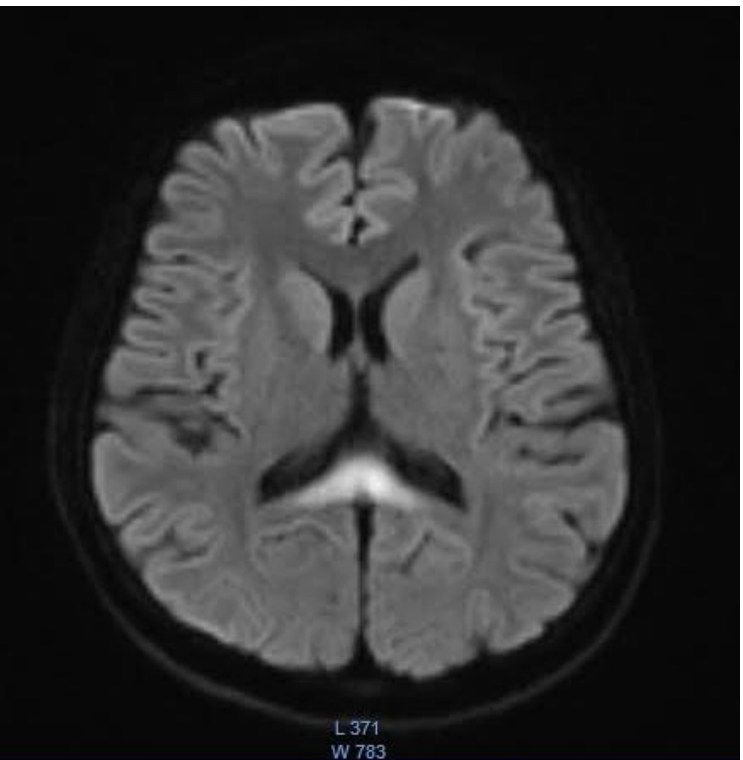
Figure 3. The DWI reveals a high-signal intensity within the splenium of the corpus callosum.